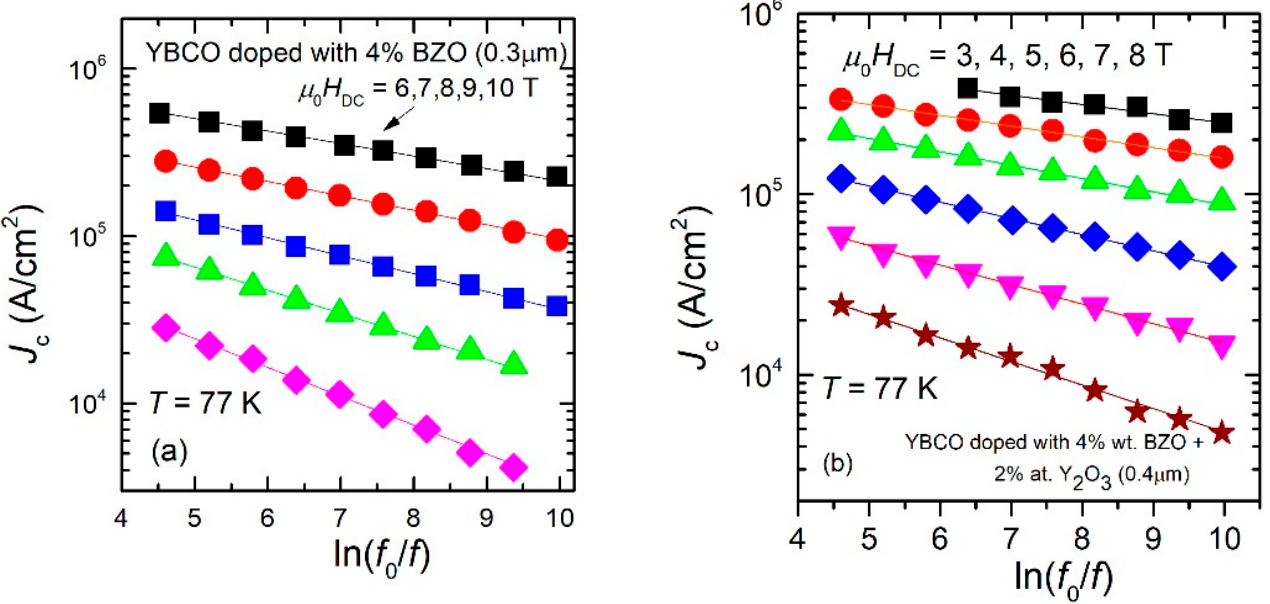
Figure 4. Frequency dependence of the critical current density of Sample 1 ( a ), and of Sample 2 ( b ) at 77 K and in DC fields indicated in the figure. All the dependences are very well described by straight lines in the double-logarithmic plot.